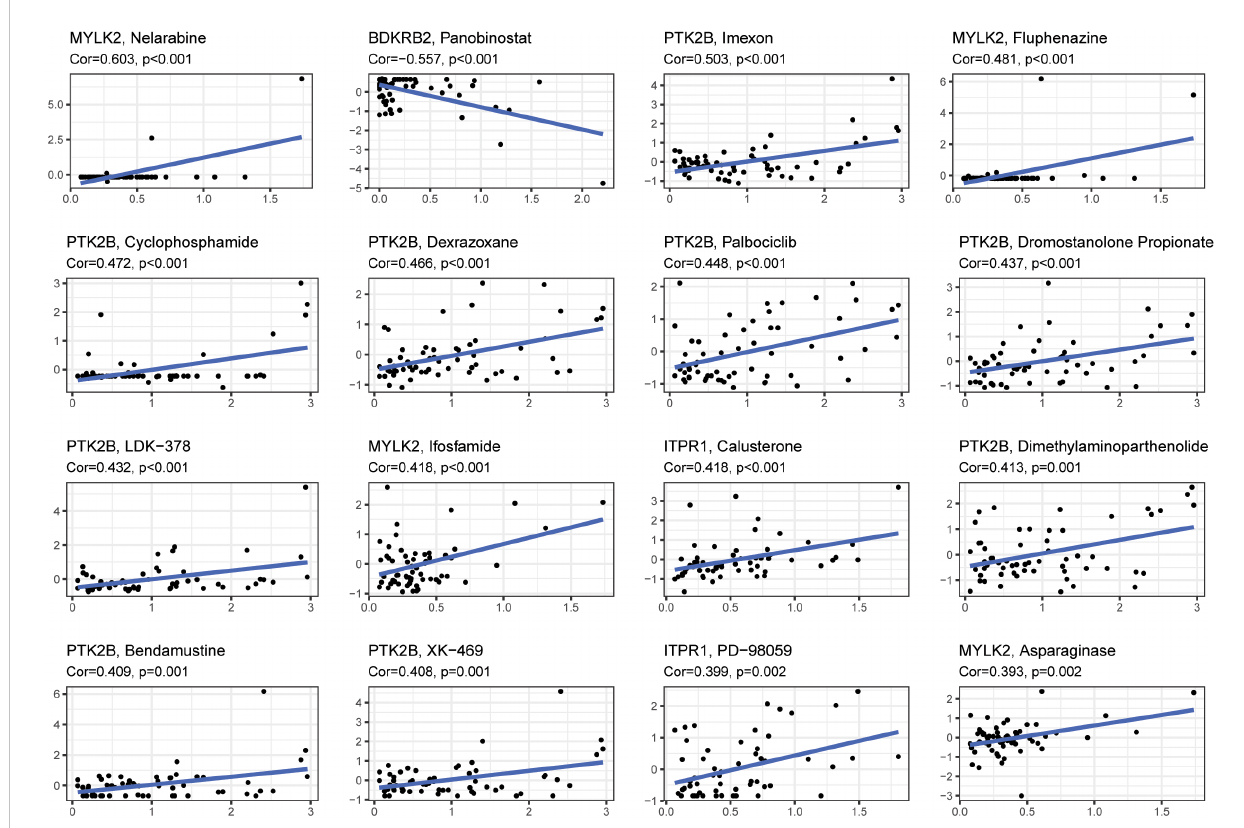
FIGURE 8 The correlation between gene expression levels and drugs. The top 16 most relevant were